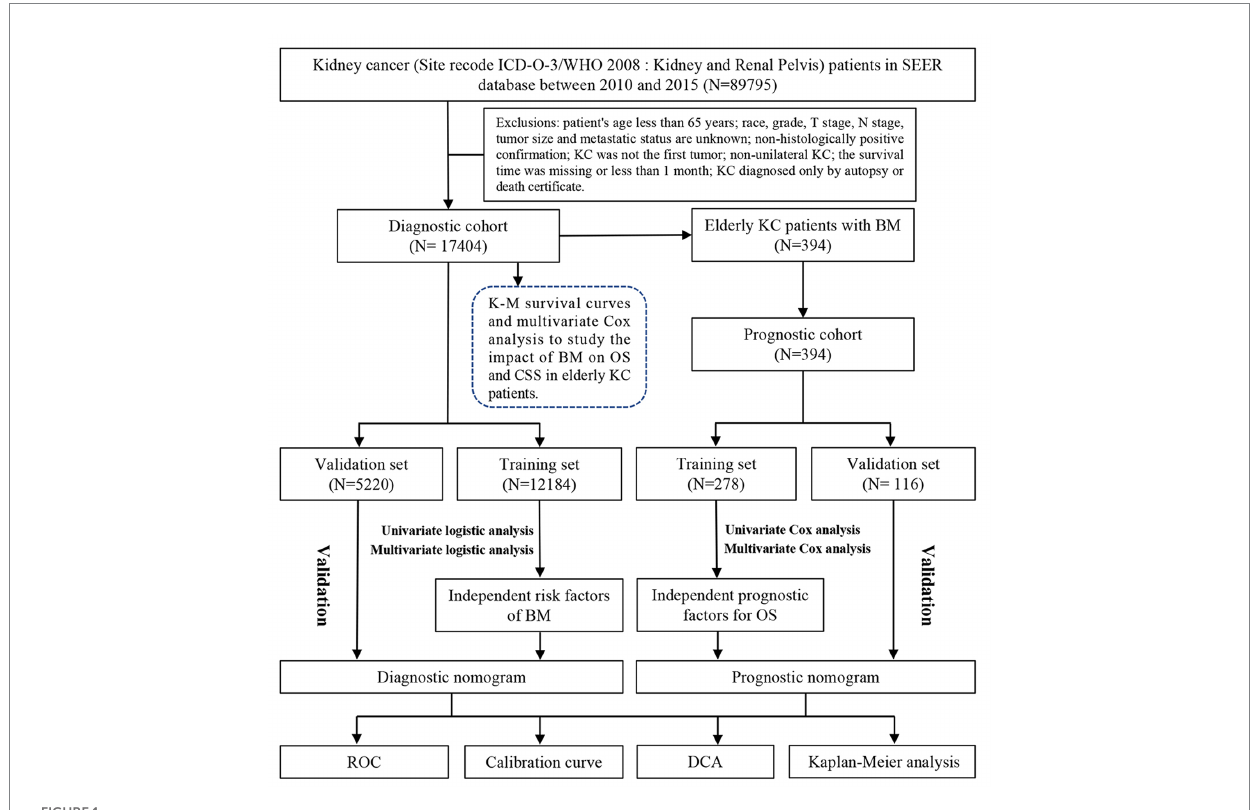
FIGURE 1 Patients’ selection and workflow of this